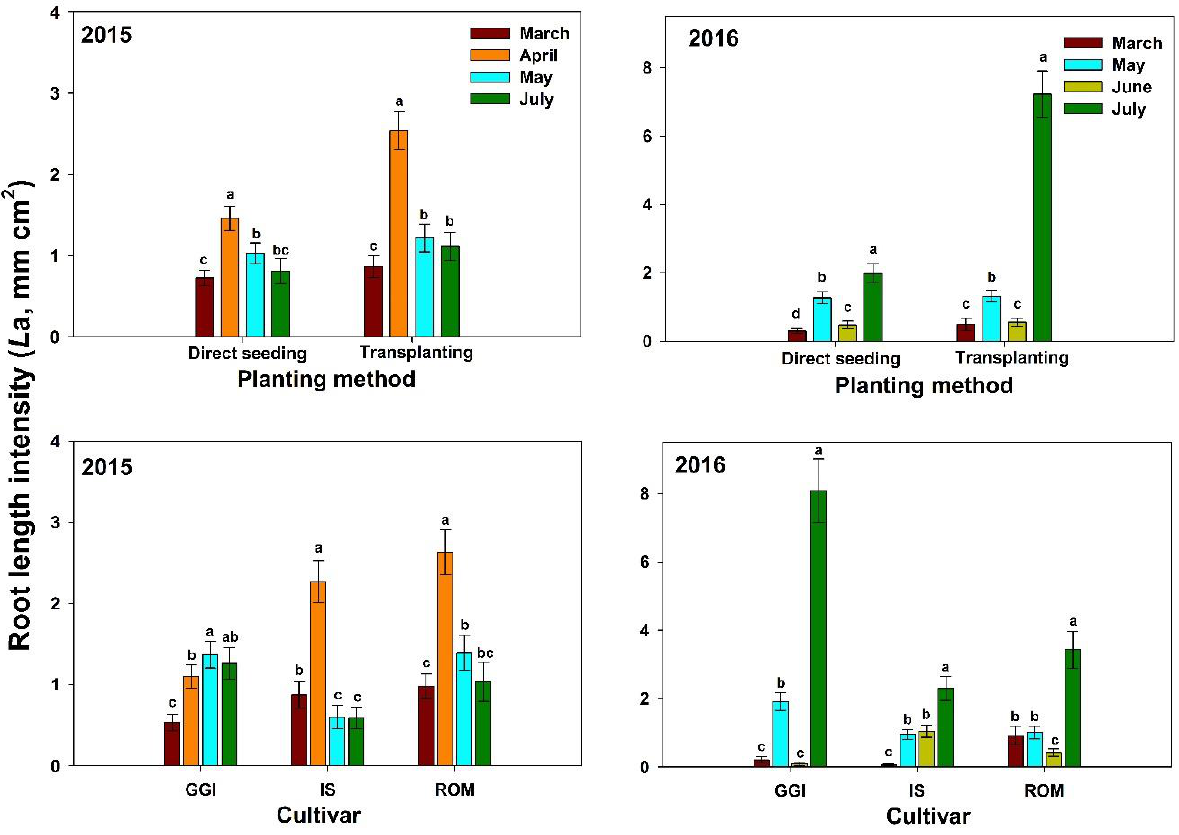
Figure 2. Mean root length intensity at soil depth 0–100 cm for artichoke cultivars (Green Globe Improved (GGI), Romolo (ROM) and Imperial Star (IS)) as influenced by planting method (direct seeding and transplanting) during 2015 and 2016 seasons. Data were collected using the minirhizotron root system. Bars within the same harvesting date followed by different letters are significantly different at p < 0.05.